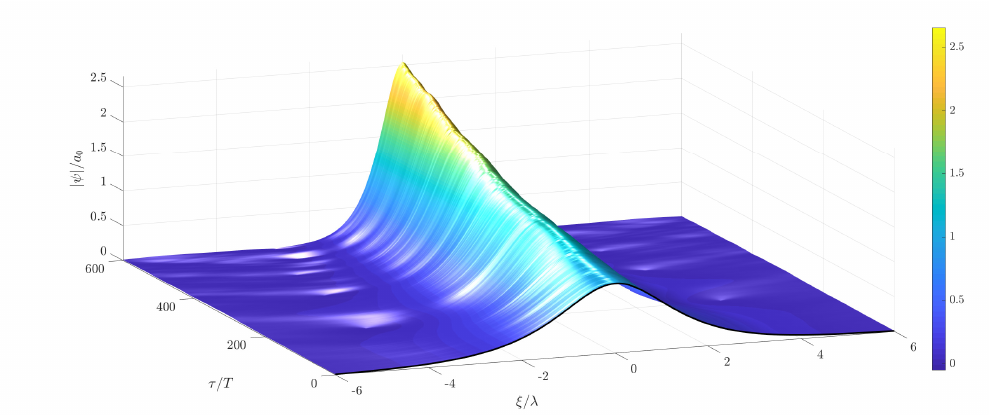
Figure 8. Temporal evolution of a soliton solution of the stochastic NLS with non-white noise excitation in time, mean wind velocity V m = 14 m/s and σ v = 10 m/s.